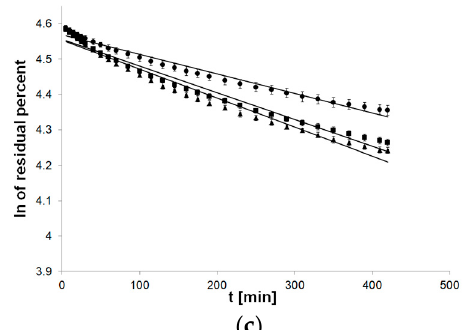
Figure 3. Process of release kinetics of β E performance according to first-order kinetics model; ( a ) MC gel formulations, ( b ) PA1 gel formulations, ( c ) gel formulations with PC-11; ▲ —reference gel, ■ —20% of MSA, ● —40% of MSA, n = 6.